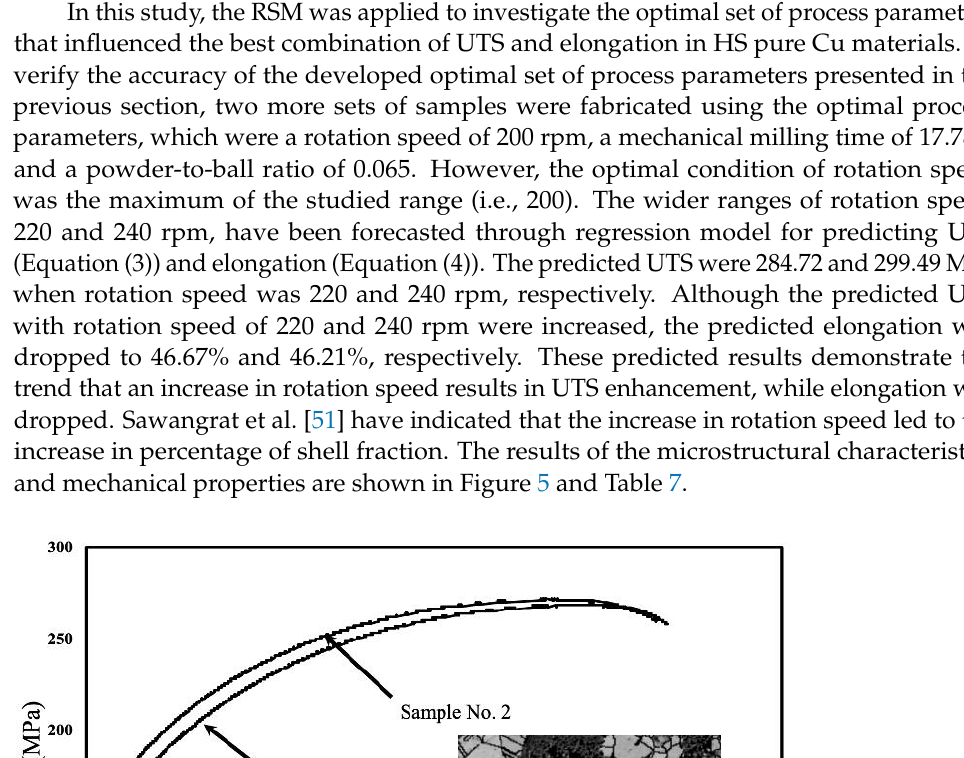
Table 7. Microstructural characteristics and mechanical properties of pure Cu specimens prepared by optimum set of process parameters in mechanical milling.